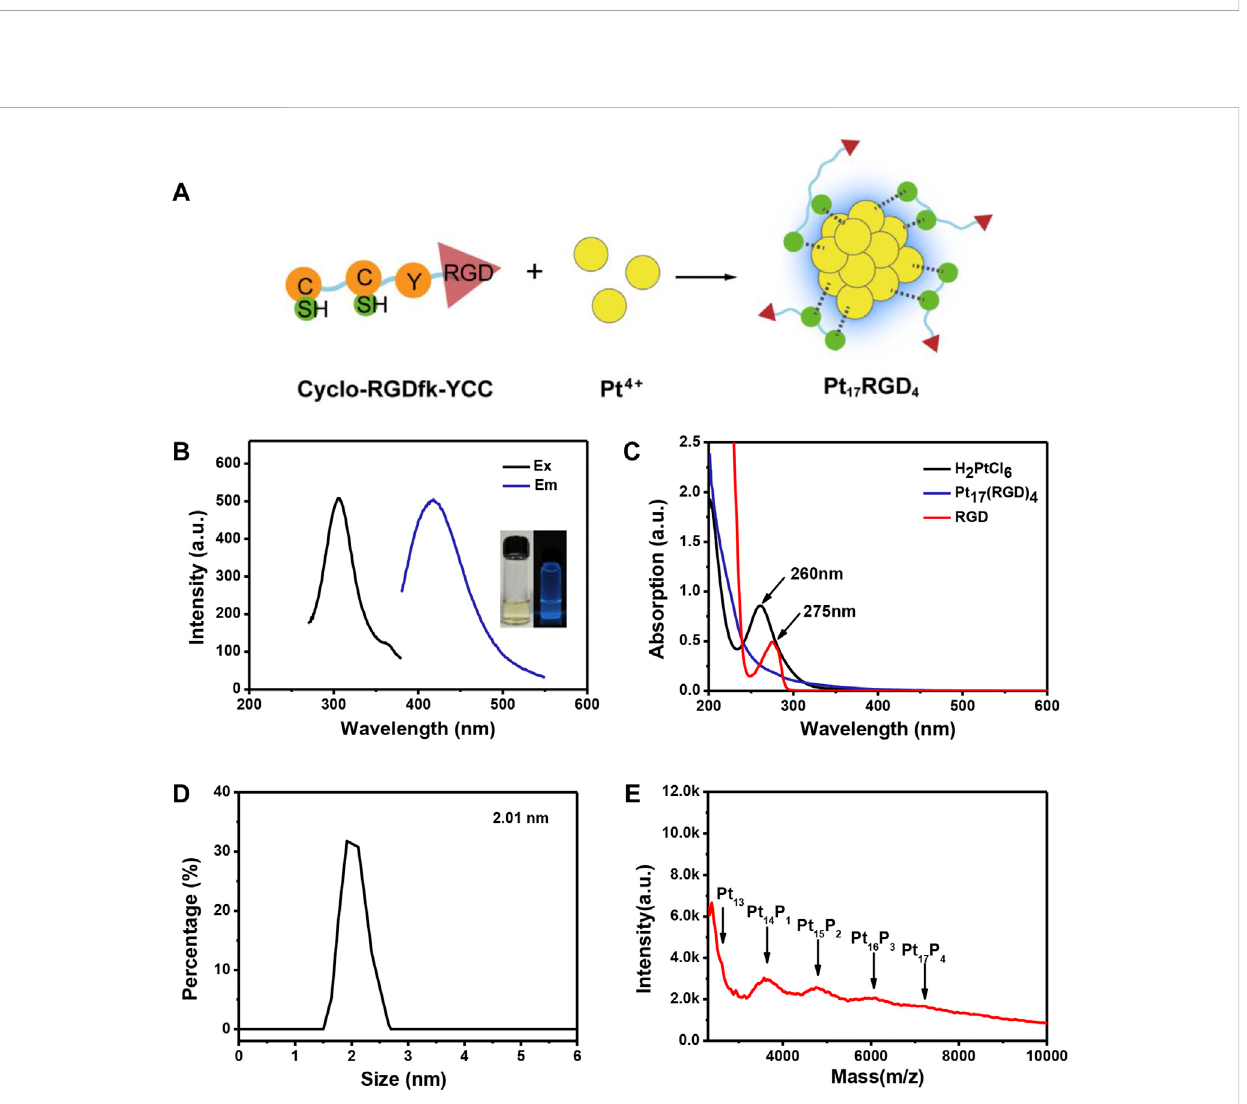
FIGURE 2 Characterization of Pt clusters. (A) Schematic diagram of the synthetic process of Pt clusters. (B) Fluorescence excitation (black line, 306 nm) and emission (blue line, 418 nm) spectra of the Pt clusters; the insets present images of the product under visible (left) and 365-nm portable UV light (right). (C) UV-Vis spectra of the RGD peptide (red line), H (D) Size distribution of the Pt clusters obtained from 2 PtCl 6 (black line), and Pt clusters (blue line). dynamic light scattering. (E) MALDI-TOF-MS analysis of Pt